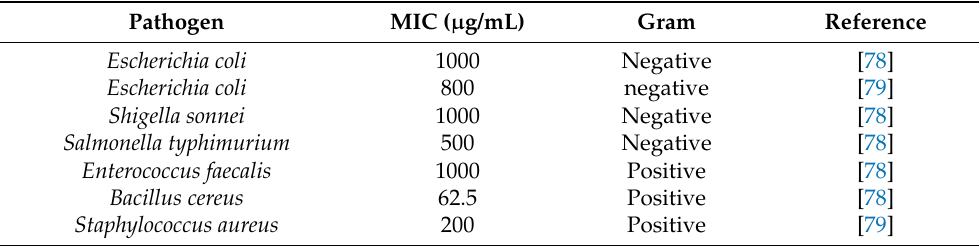
Table 4. Main MIC values for